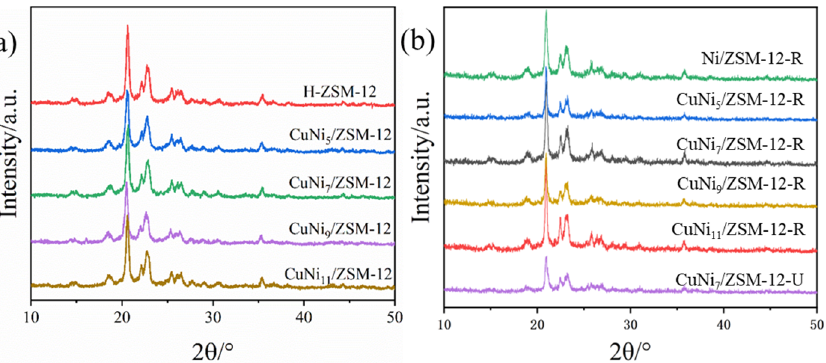
Figure 1. ( a ) XRD patterns of H-ZSM-12 and CuNi x /ZSM-12 catalysts, ( b ) XRD patterns of the catalyst after reduction.